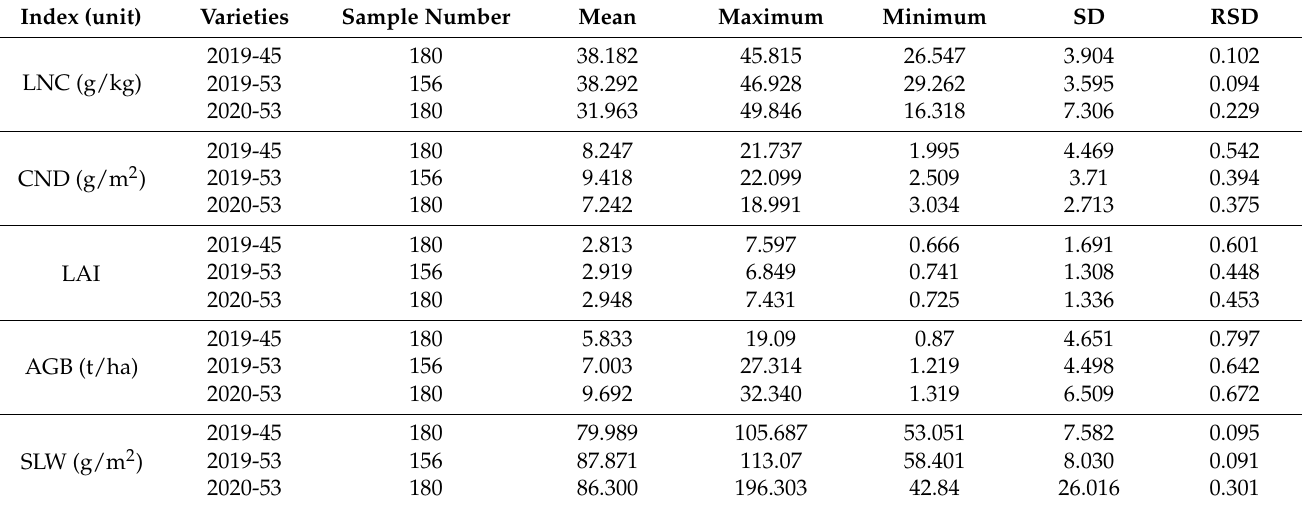
Table 5. Overall characteristics of samples in the entire growth